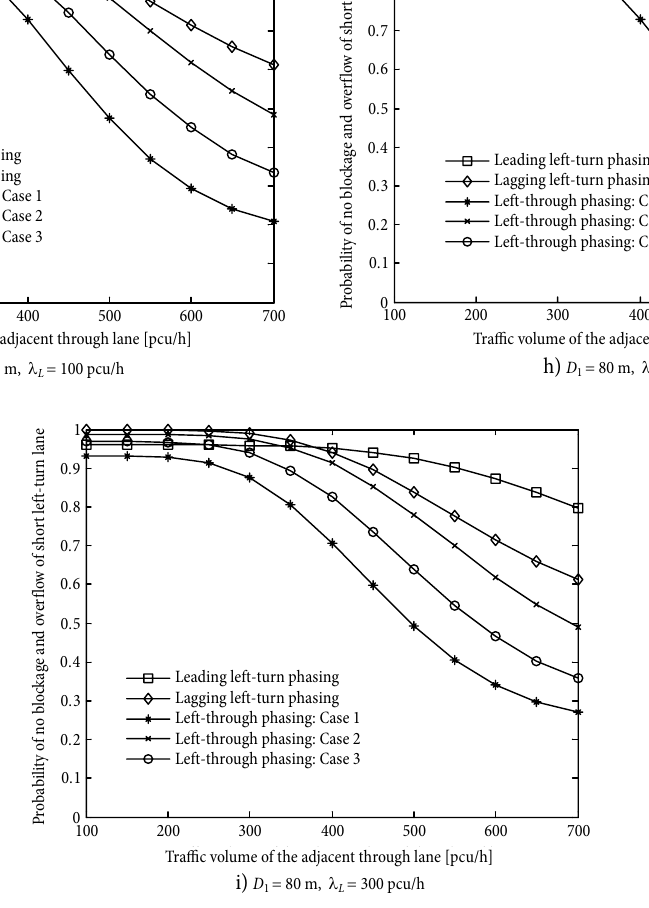
Fig. 4. Comparison of the probabilities of no blockage and overflow of the short left-turn lane under different signal phase